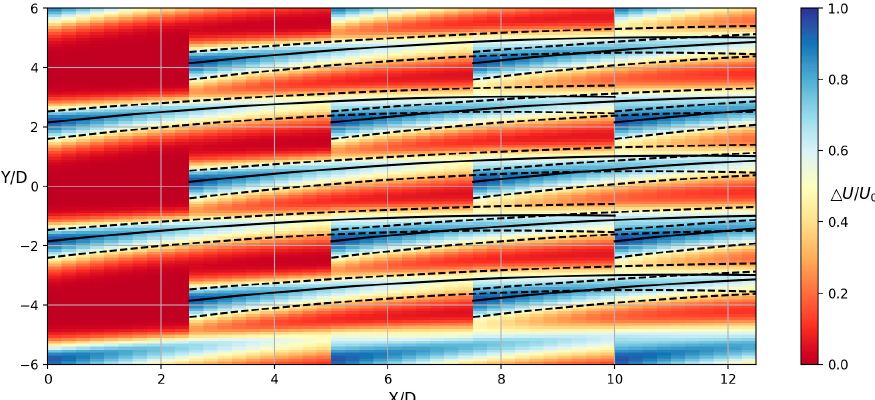
Figure 18. The velocity contour of the array, which is the optimal arrangement under the criterion of array power density (truncation ratio is 0.7). y 1 = 4, x 2 = 2.5, y 2 = 2. The color bar is the velocity deficit, the black solid lines represent the position of the maximum velocity deficit, and the black dashed lines represent the deviations of the double semi Gaussian func-